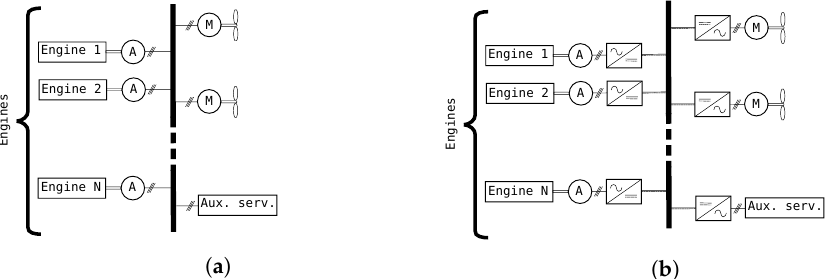
Figure 1. Generation and propulsion system layout types: AC distribution network, constant revolution speed D/G ( a ) and DC distribution network, variable revolution speed D/G ( b